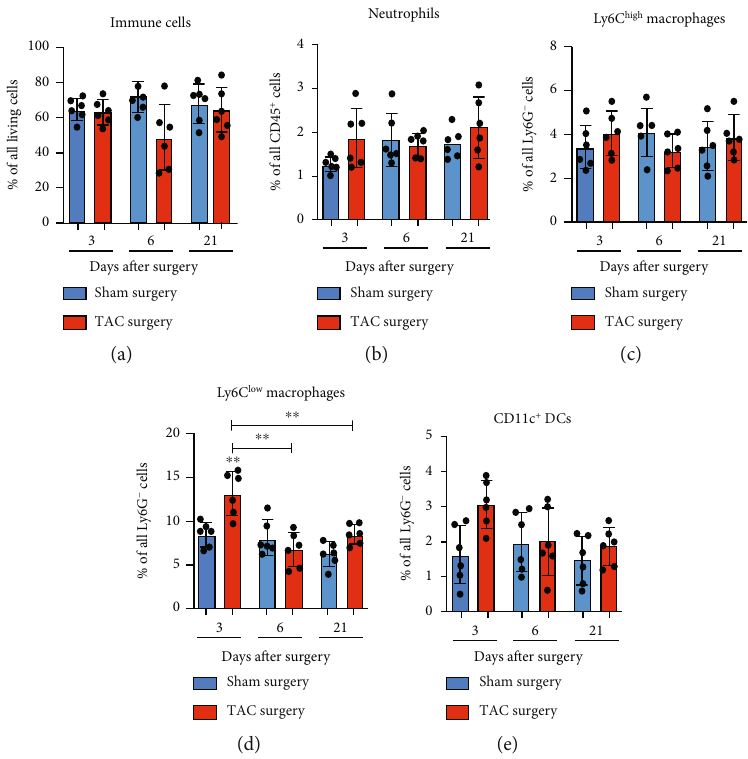
Figure 3: Innate immune response in the spleen. (a) – (e) The CD45 + immune cells, neutrophils, and Ly6C low and Ly6C high macrophages, and DCs in the spleen of the mice were quanti fi ed via fl ow cytometry. The particular cell subsets were de fi ned as follows: neutrophils as CD45 + F4/80 - Ly6G + and macrophages as CD45 + F4/80 + Ly6G - . Moreover, the Ly6C high and Ly6C low macrophages were further discriminated according to the respective Ly6C surface expression, and the DCs were de fi ned as CD45 + F4/80 - Ly6G - and CD11c + . ∗ The above individual columns indicate the signi fi cant di ff erences between the TAC and respective sham group; ∗ P < 0 : 05 , and ∗∗ P < 0 : 01